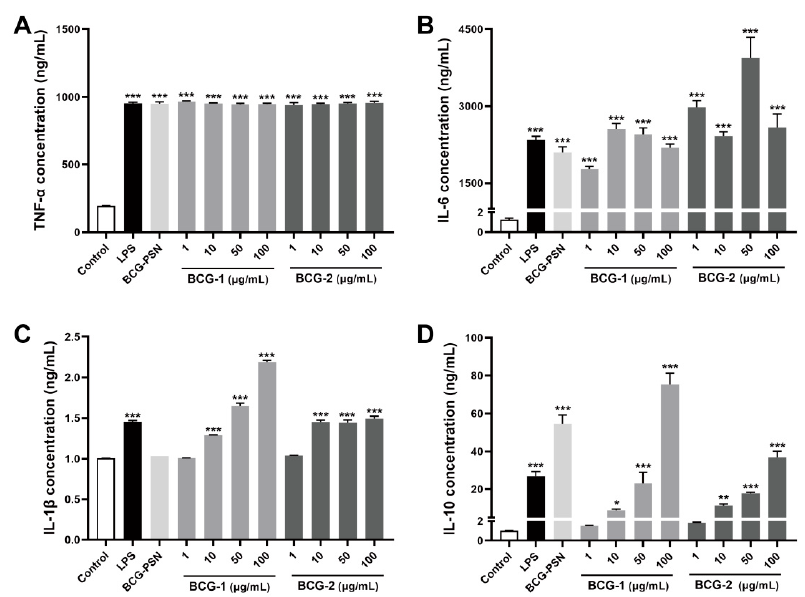
Figure 6. Effects of LPS, BCG-PSN, BCG-1, and BCG-2 on cytokines TNF- α ( A ), IL-6 ( B ), IL-1 β ( C ), IL-10 ( D ) produced by the RAW 264.7 cells. LPS was at 100 ng/mL, BCG-PSN was at 87.5 μ g/mL. * p < 0.05, ** p < 0.01, and *** p < 0.001 vs. control, one-way ANOVA, Dunnett’s multiple comparisons test.